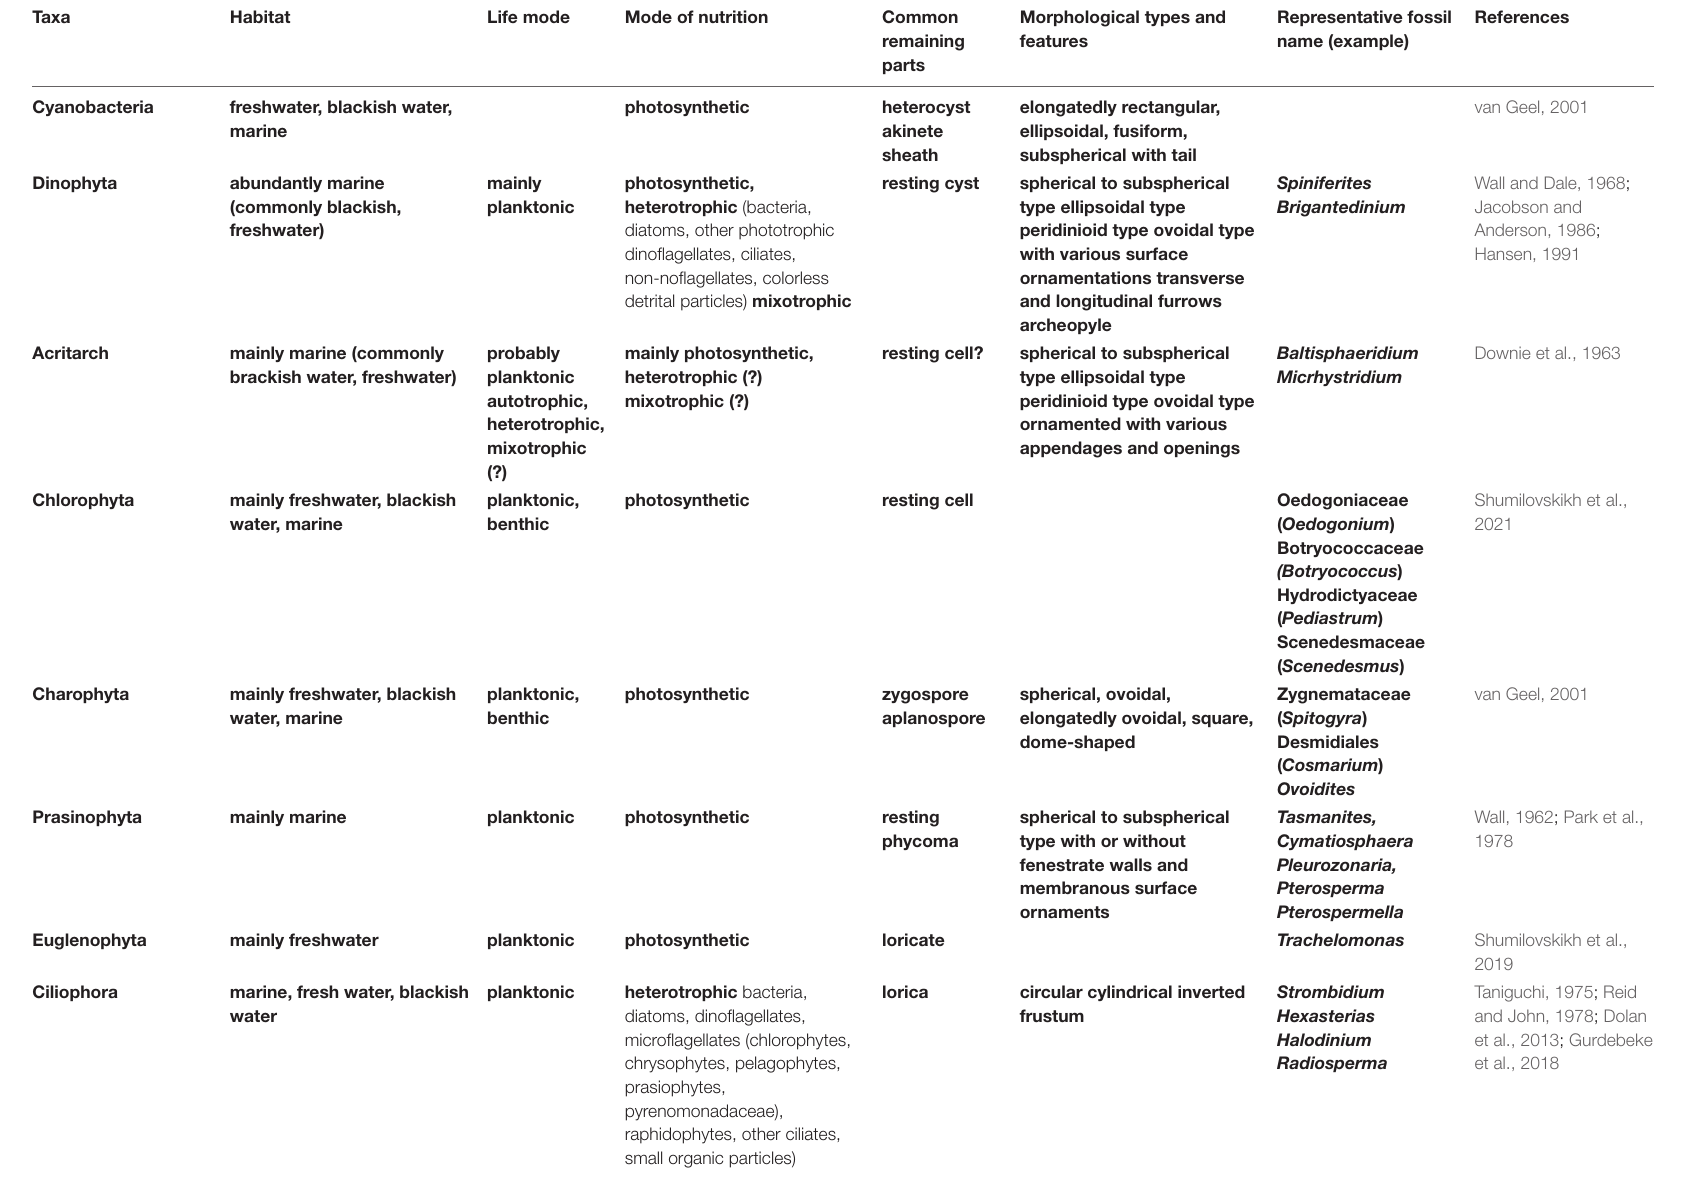
TABLE 1 | Aquatic